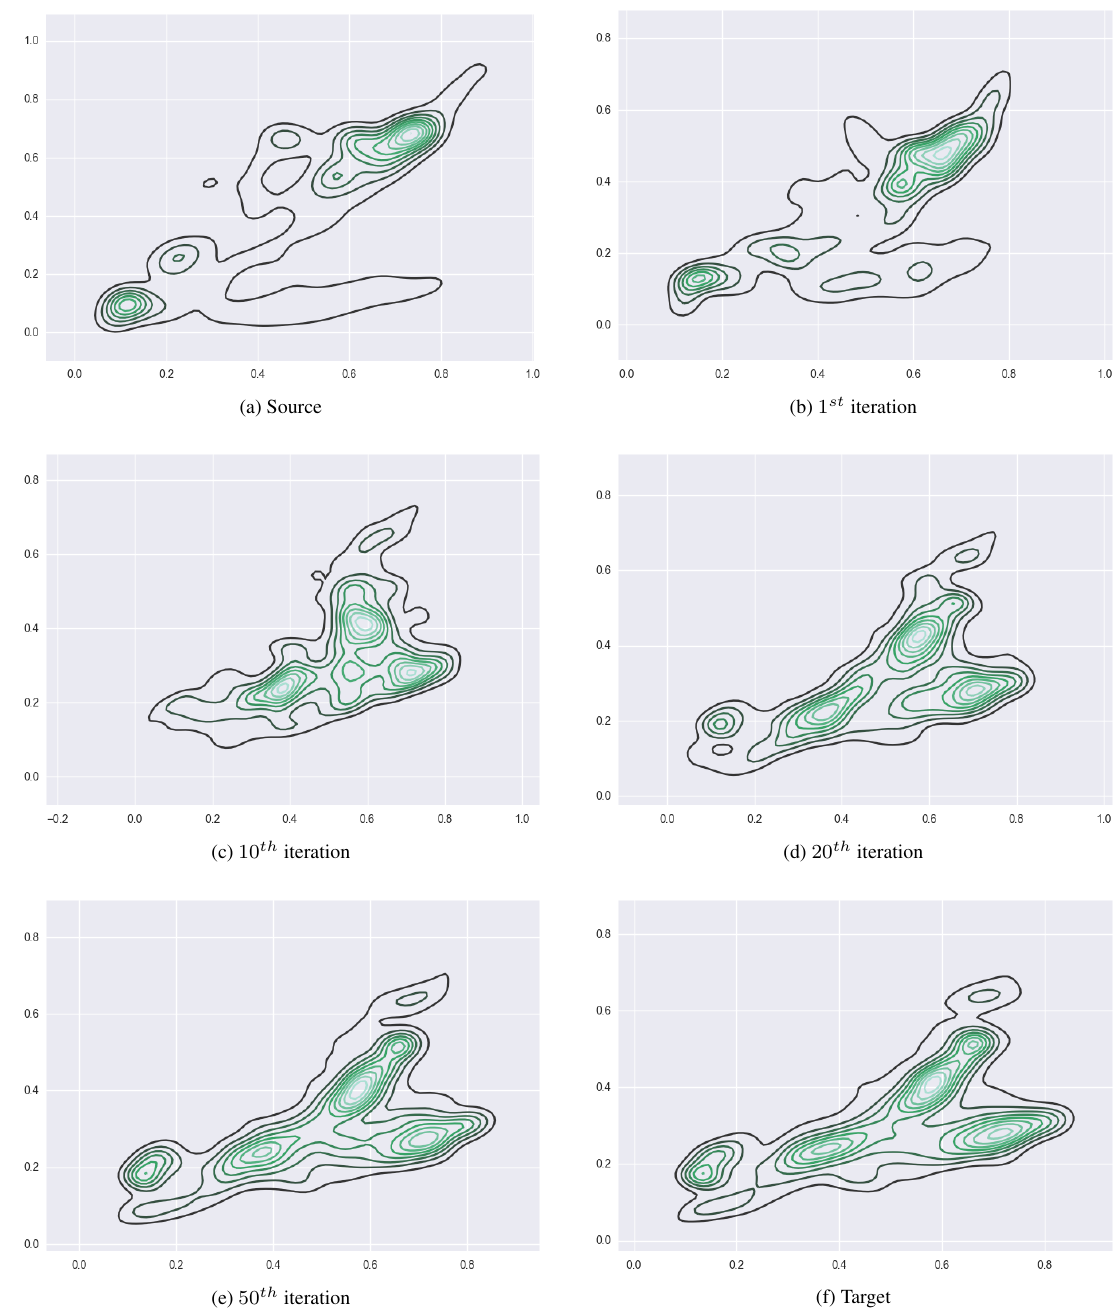
Figure 1: The evolution of source probability distribution function. The bivariate probability distribution of the red and green bands of the source data is shown in Figure 1a. The target probability distribution function is presented in Figure